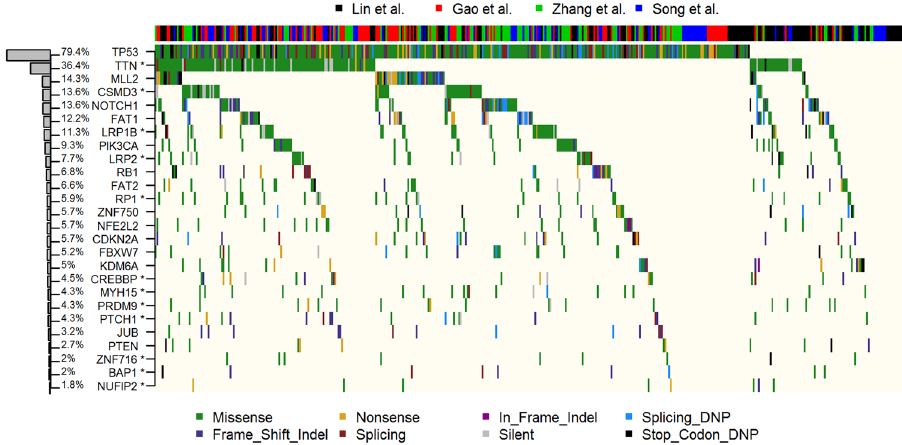
Figure 1. Landscape of the significantly mutated genes in ESCC. Top: four datasets. Left: SMGs were sorted according to mutation frequency in 442 patients, total number of somatic mutations of each gene, and the percentages indicated the fraction of patients with the individual mutation. Genes marked with an asterisk have a q value of < 0.2 in the MutSigCV analysis. Middle: mutations in 26 frequently mutated genes across 442 ESCC samples. Each column represents an individual, each row represents a gene, and mutation subtypes are denoted by